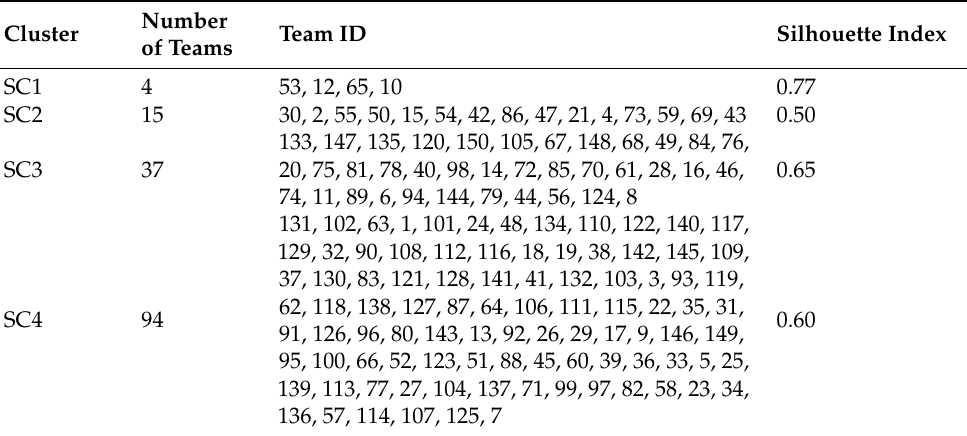
Figure 8. Silhouette Widths for each cluster. Table 3. Number of teams in each cluster and Silhouette